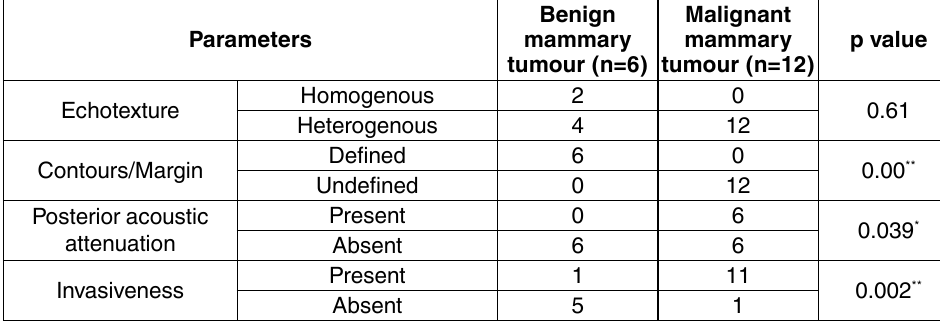
table 1. B-mode ultrasound features of mammary neoplasms (n=18)